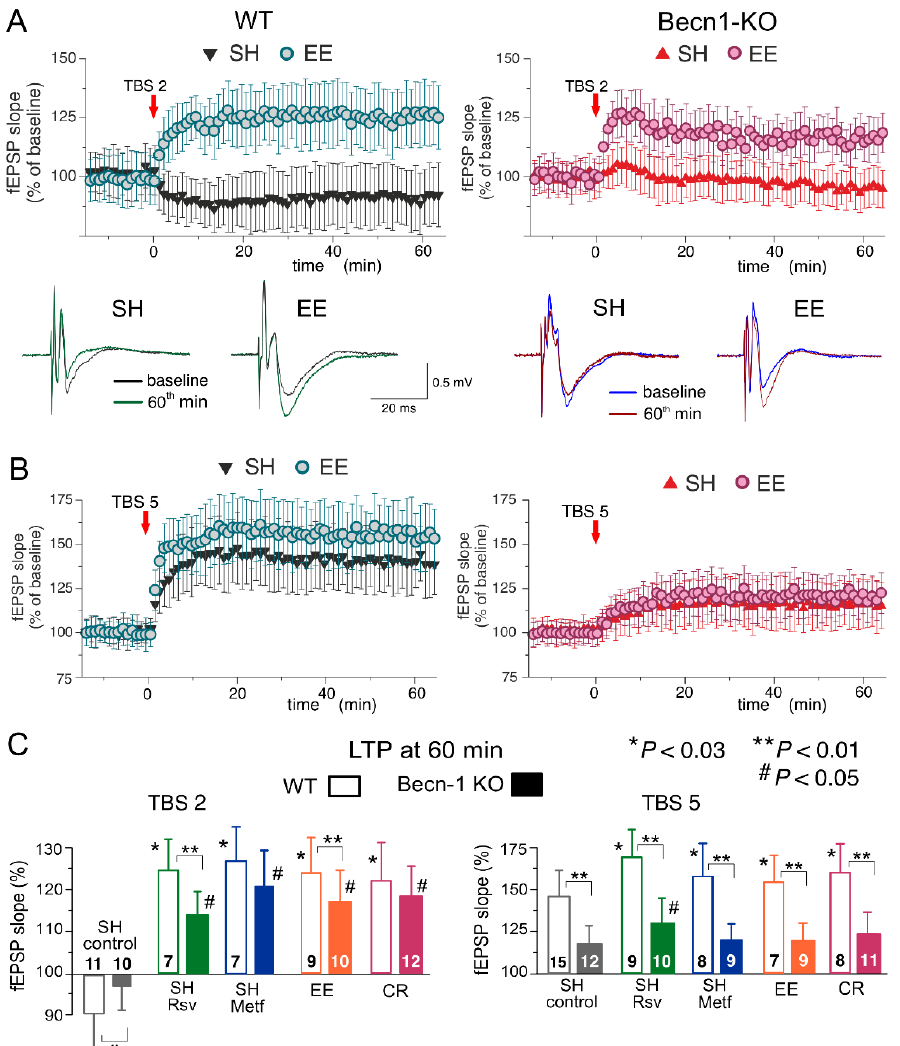
Figure 7. Impact of autophagy impairment on long-term synaptic plasticity in the neocortex. The LTP of the field EPSPs was induced in the layer 2/3 neurons of the somatosensory cortex of the wild-type and Beclin1-deficient mice by two ( A ) or five ( B ) episodes of theta-burst stimulation (TBS), as described in Methods . ( A , B ) The time course of changes in the slopes of fEPSPs recorded in the mice in standard housing (SH) and mice exposed to the enriched environment (EE). Dots in the graphs represent the average of six consecutive fEPSPs; data are shown as means ± SDs for 7 – 15 experiments (as indicated in panel C ). Data were normalized to the fEPSP slope averaged over the 10 min period prior to the TBS. The insets show the representative average fEPSP waveforms recorded in the SH and EE mice of corresponding genotype before and 60 min after the TBS. ( C ) The pooled data on the magnitude of the LTP in the neocortex of mice of both genotypes at different conditions. In the SH mice, the LTP was evaluated in the control or after preincubation of brain slices with metformin (Metf) or resveratrol (RSV) for >4 h, as shown in Figures 5 and 6. Graphs show the magnitude of LTP evaluated as relative increase in the fEPSP slope at 60 min, averaged across a 10 min time window. Data are shown as means ± SDs for the numbers of experiments indicated. Statistical significance (two-population unpaired t -test) for the differences between genotypes and treatment groups is indicated by different symbols, as follows: (*) effect of EE, CR or drug in the WT mice as compared to the control; (#) effect of EE, CR or drug in the Beclin1-deifient mice as compared to the control; (**) difference between the WT and Beclin1-deficient mice. Note the significant decrease in the LTP magnitude in Beclin1-KO mice.